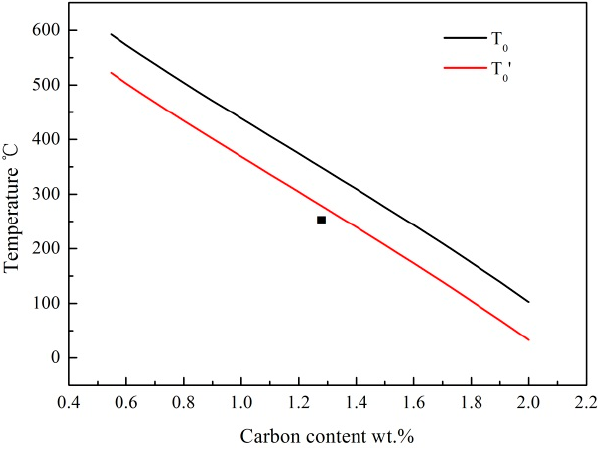
Figure 7. The calculated T 0 and T 0 (cid:48)